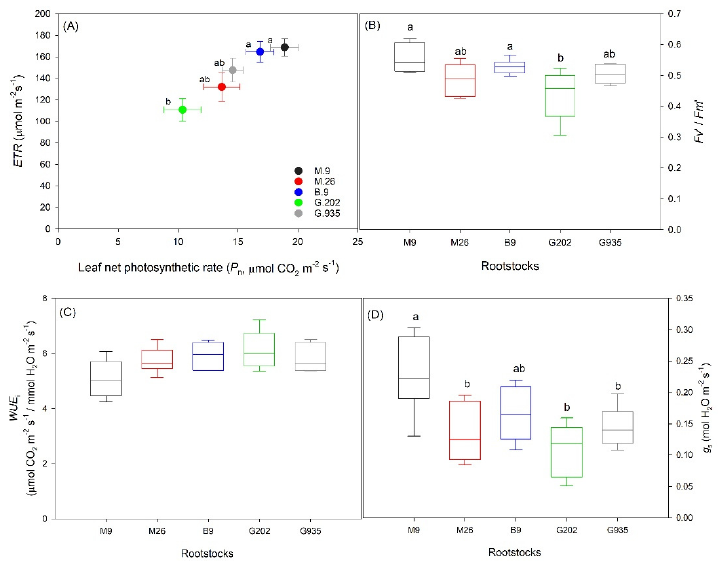
Figure 7. Leaf net photosynthetic rate P n and electron transport rate ( ETR ) ( A ), chlorophyll fluorescence Fv ’/ Fm ’ ( B ), instantaneous water use efficiency WUE i ( C ), and stomatal conductance g s ( D ) of Ambrosia TM apples on five rootstocks at the onset of heat stress in the second-year planting. Different letters in each sub-panel stand for significant differences amongst rootstocks ( P ≤ 0.05, ANOVA, Tukey–Kramer pairwise comparisons; n = 6). The absence of letters stands for no significant differences.